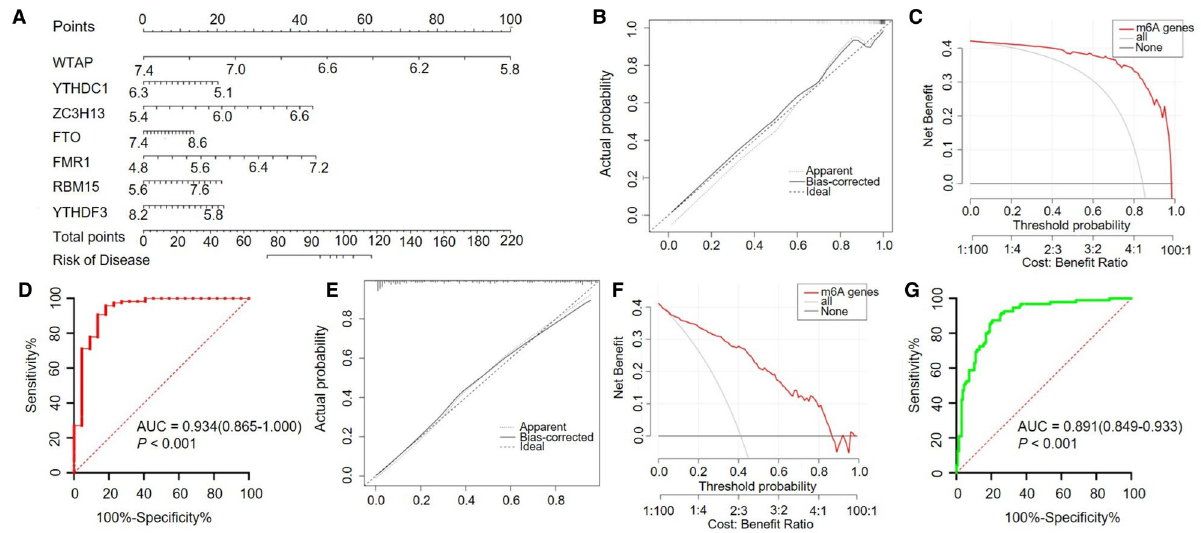
Figure 3. Construction and validation of a predictive nomogram for ICM established based on seven m6A regulators. ( A ) The constructed nomogram. The calibration plot, DCA and ROC analysis of the nomogram in the training set ( B , C , D ) and in the testing set ( E , F , G ). ( B , E ) The diagonal dotted lines represent a perfect prediction using an ideal model. ( C , F ) The solid lines represent the performance of the nomogram, of which a closer fit to the diagonal dotted line represents a better prediction. ( D , G ) ROC analysis reconfirmed that the model was effective in distinguishing ICM patients from healthy